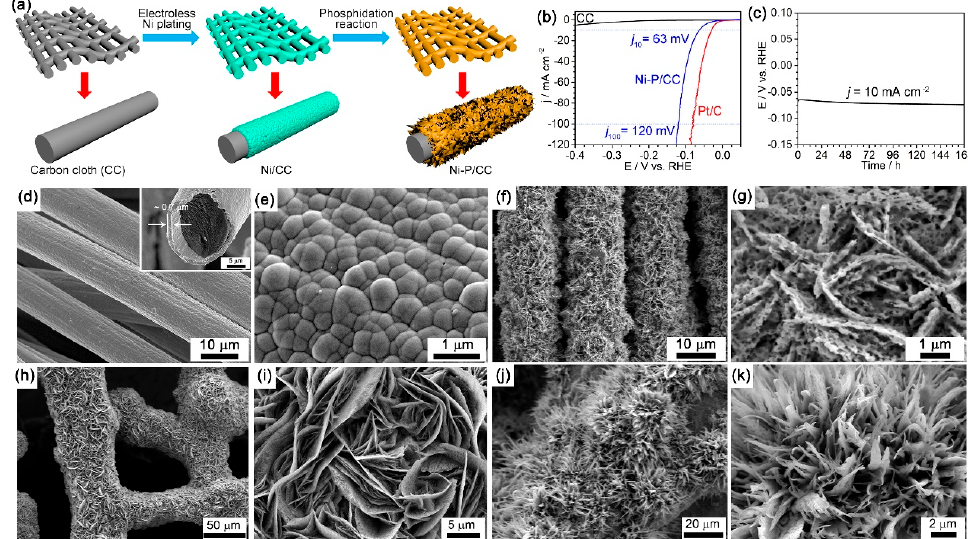
Figure 10. Schematic illustration for preparation of porous nickel phosphide nanosheets on carbon cloth ( a ), polarization curves for the carbon cloth (CC), Pt / CC, and Ni-P / CC electrode in 0.5 M H 2 SO 4 ( b ), time-dependent potential curve of the Ni-P / CC-60-450 in 0.5 M H 2 SO 4 electrolyte under a constant current density of 10 mA cm − 2 for 168 h ( c ). Low- ( d ) and high- ( e ) magnification SEM images of the Ni / CC-60. Inset in ( d ) is a typical cross-sectional SEM image of one fiber in the Ni / CC-60. Low- ( f ) and high- ( g ) magnification SEM images of the Ni-P / CC-60-450. SEM images of the Ni-P / LV ( h , i ) and Ni-P / SC ( j , k ). Reproduced with permission from Reference [120], Copyright The American Chemical Society, 2019.